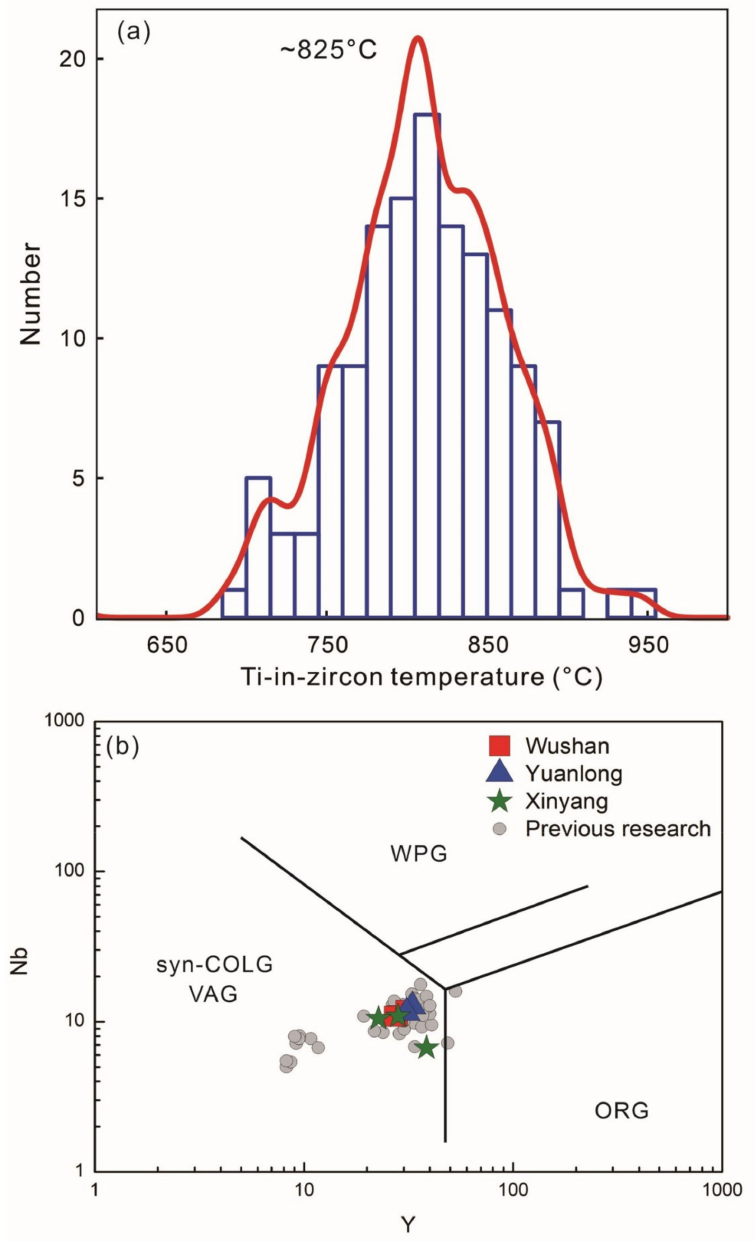
Figure 13. ( a ) Ti-in-zircon temperature [127] histogram with probability density plot for the studied granitic mylonites and granitic gneisses from the western margin of the NQT. ( b ) Nb–Y diagram [135] for the studied granitic mylonites from Wushan and granitic gneisses from Yuanlong and Xinyang. Data sources for the previous research: [19,39–42,52]. VAG—volcanic arc granites; ORG—ocean ridge granites; WPG—within plate granites; Syn-COLG—syn-collision